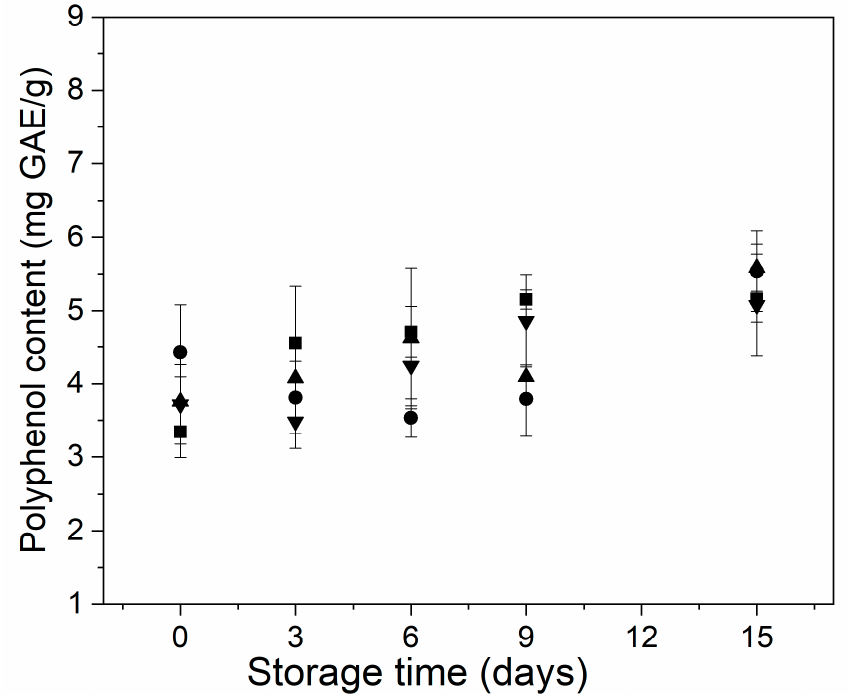
Figure 6. Behavior of the content of phenolic compounds of control and treated minimally processed bunching green onion during storage. Control ( ■ ); mild-heat treatment ( ● ); edible coating ( ▲ ); mild- heat treatment+ edible coating ( ▼ ).